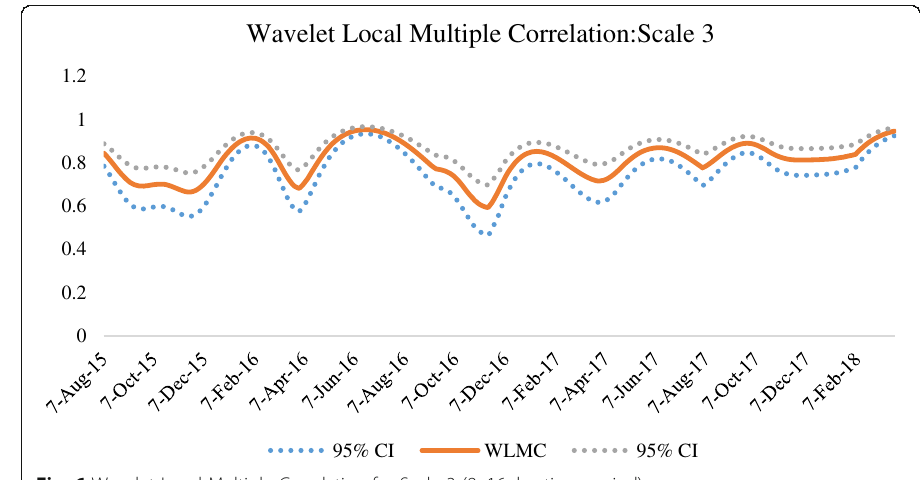
Fig. 6 Wavelet Local Multiple Correlation for Scale 3 (8 – 16 day time